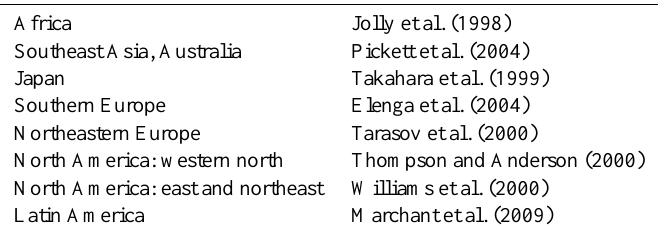
Table 1. Details of the various biomization schemes applied for the different